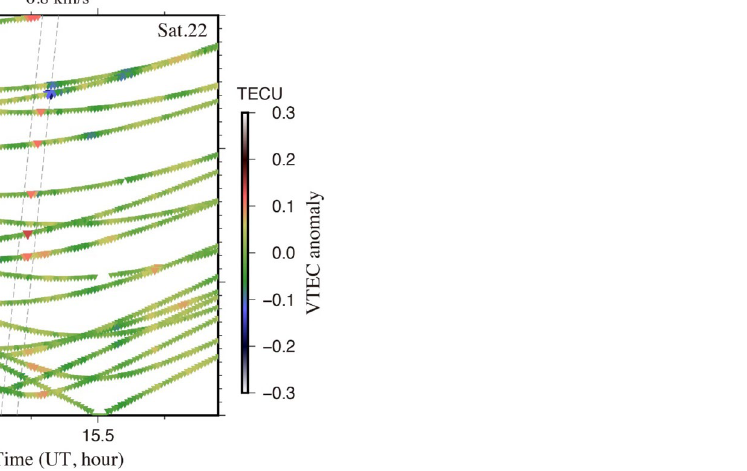
ϕ = ( z = h c )/ h and the altitude of largest electron density h c was set to 300 km, and h is assumed 65 km (Fig. 4a).